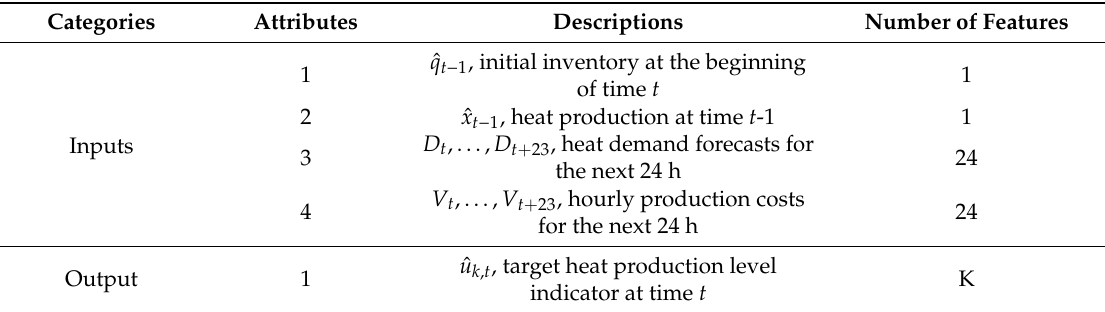
Table 2. Inputs and output used for the proposed heat production planning model